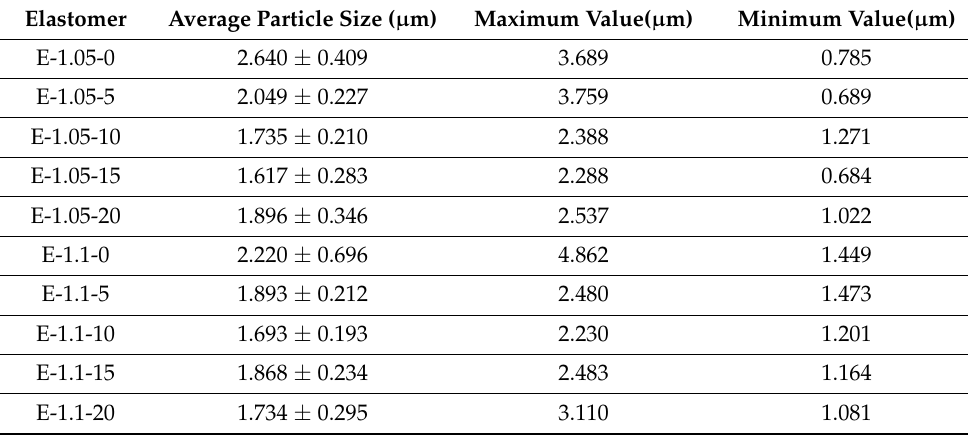
Table 2. Average particle size of the elastomer polymeric matrices. Elastomer Average Particle Size ( µ m) Maximum Value( µ m) Minimum Value( µ